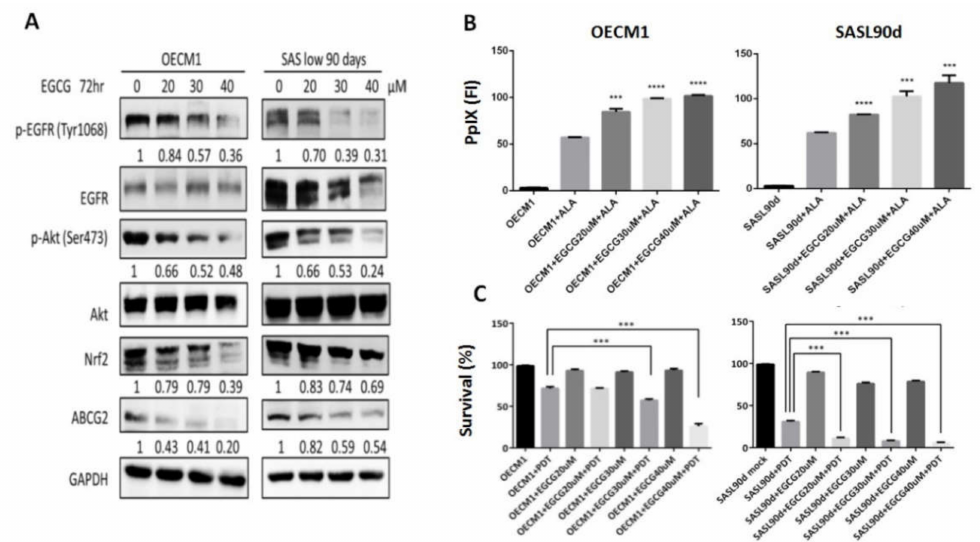
Figure 3. EGCG treatment suppresses ABCG2 expression, increases PpIx accumulation, and decreases ALA-PDT mediated-HNC cell viability. ( A ) Western blot analysis for p-EGFR (Y1068), p-Akt (S473), Nrf2, and ABCG2 expression in OECM1 and SASL90d cells treated with di ff erent concentrations of tea polyphenol EGCG. EGCG inhibited EGFR and Akt signaling activities as well as ABCG2 and Nrf2 expression. In OECM1 and SASL90d, EGCG treatment ( B ) upregulated PpIX accumulation and ( C ) decreased cell viability in a dose-dependent manner. n ≥ 3; *** p < 0.001, **** p < 0.0001.